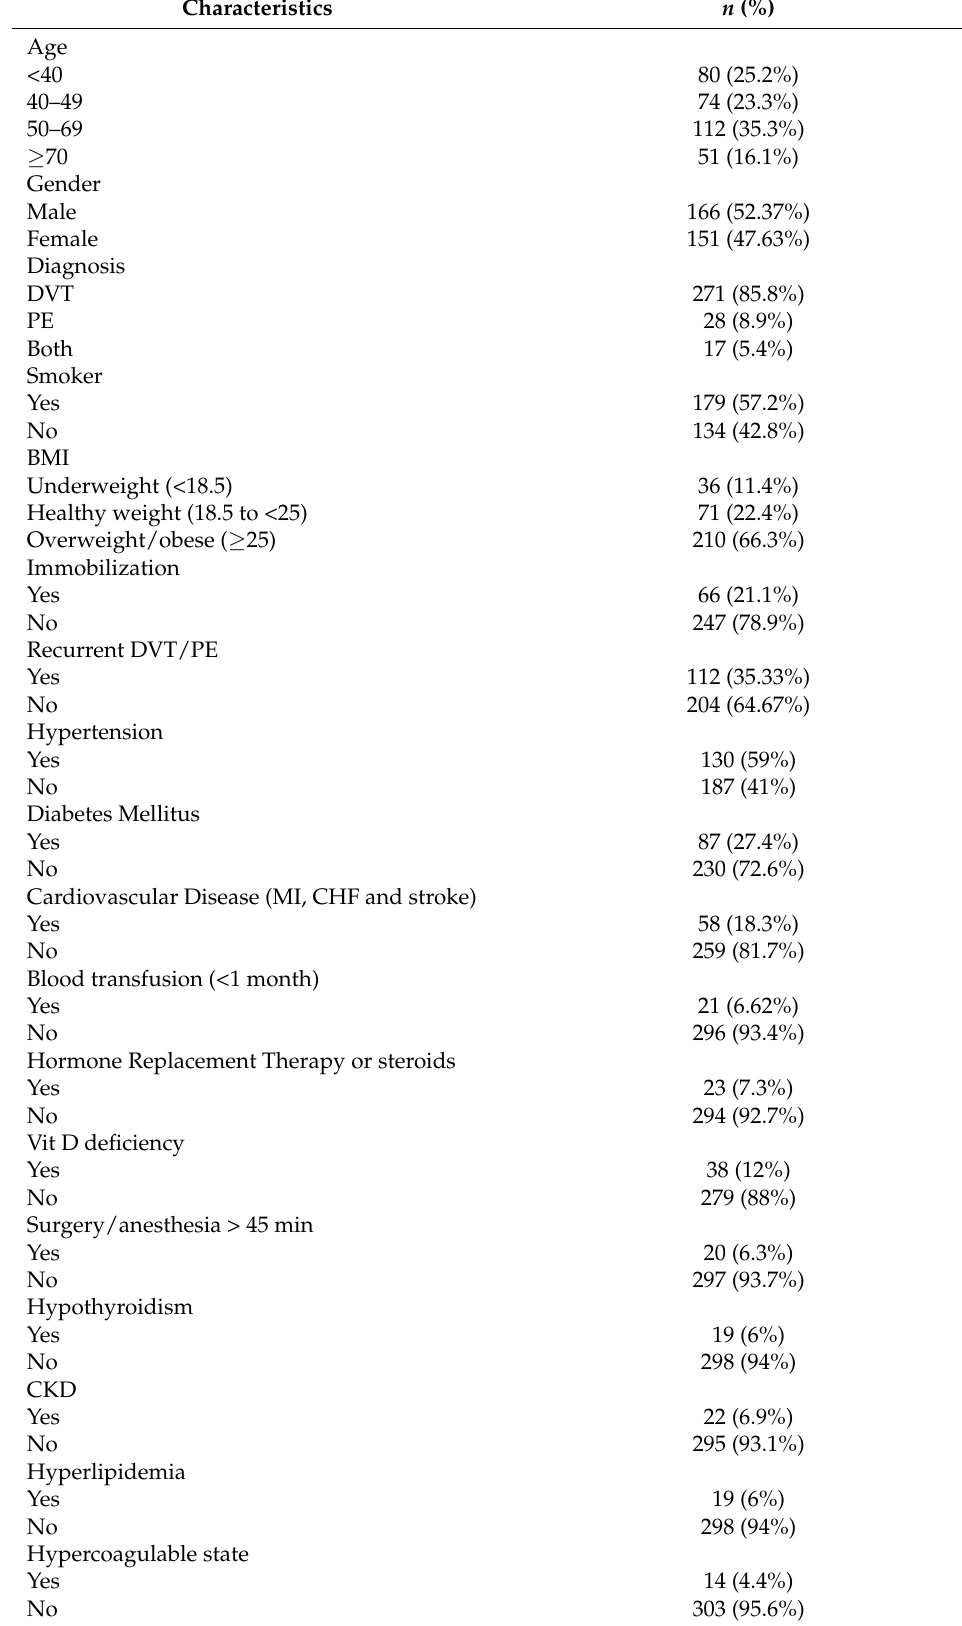
Table 2. Characteristics of Patients Admitted with Venous Thromboembolism ( n =